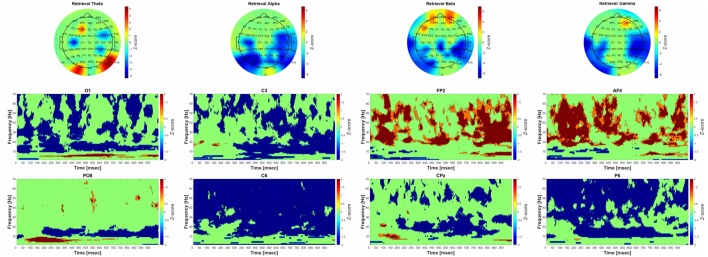
Significant group-level changes in the power of the different frequency bands during retrieval. The power of the investigated four frequency bands (theta, alpha, beta, gamma) during retrieval were compared to the baseline activity using nonparametric permutation test with correction for multiple comparisons at the minimum-maximum point of the null-hypothesis distribution. The upper part of the figure shows the FFT results of the 64 channel EEG recordings in topographic representation in different frequency band during retrieval, while the lower part of the figure corresponds to the group-level time-frequency results in different channels (O1, C3, FP2, AF4, PO8 C6, CPz, P6, respectively). The color scales beside the upper three panels indicate the z-score values, obtained by calculating cluster-mass statistics in individual power changes between retrieval and baseline activity. The red color indicates significant power-increase and the blue color represents significant power-decrease compared to baseline. The z-scores threshold was set to 1.645 (which is equal to the 0.05 p-value).